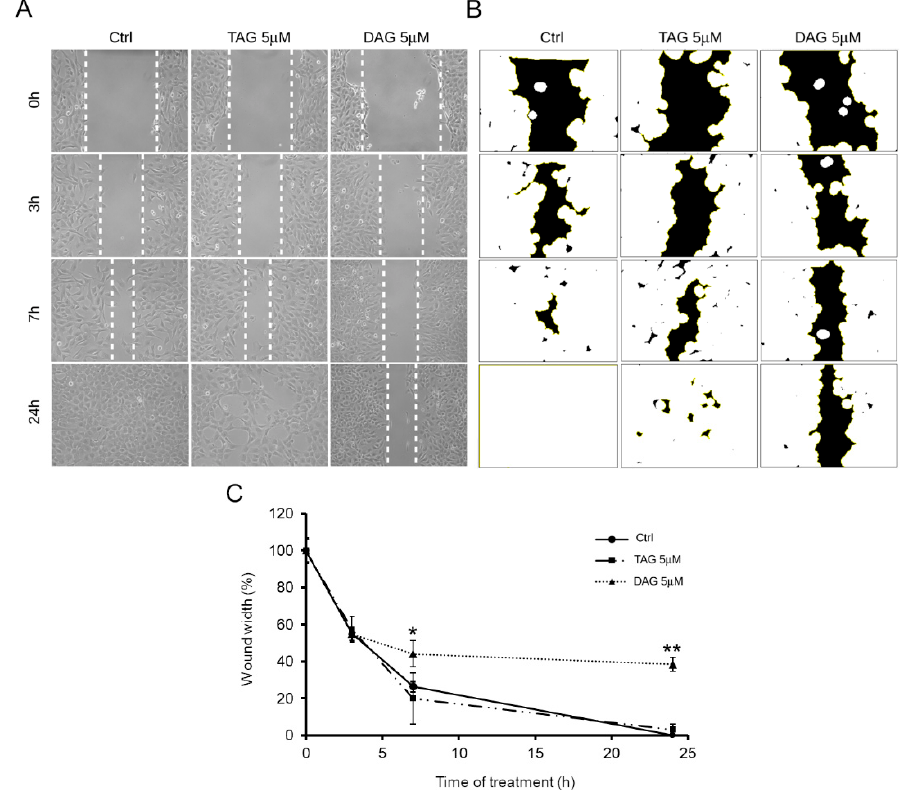
Figure 5. Effect of TAG or DAG on SH-SY5Y cell migration. ( A ) Wound healing assay on SH-SY5Y cells treated with vehicle (Ctrl) or with 5 μ M of TAG and DAG. Scratch closure was monitored up to 24 h. Dashed lines mark the edges of the wound area. ( B ) Representative image of wound width (black area) obtained by the image analysis software ImageJ for the quantitative analysis ( C ) Time course analysis of scratch closure in TAG and DAG treated cells or control cells. The wound width for each time point was measured and quantified by using the image analysis software ImageJ. Mean values of wound width at the various time points were reported in percentage terms relative to time 0. Values are represented as means ± SD from three different experiments. Tukey’s test. * p < 0.05; ** p < 0.01 vs. Ctrl.